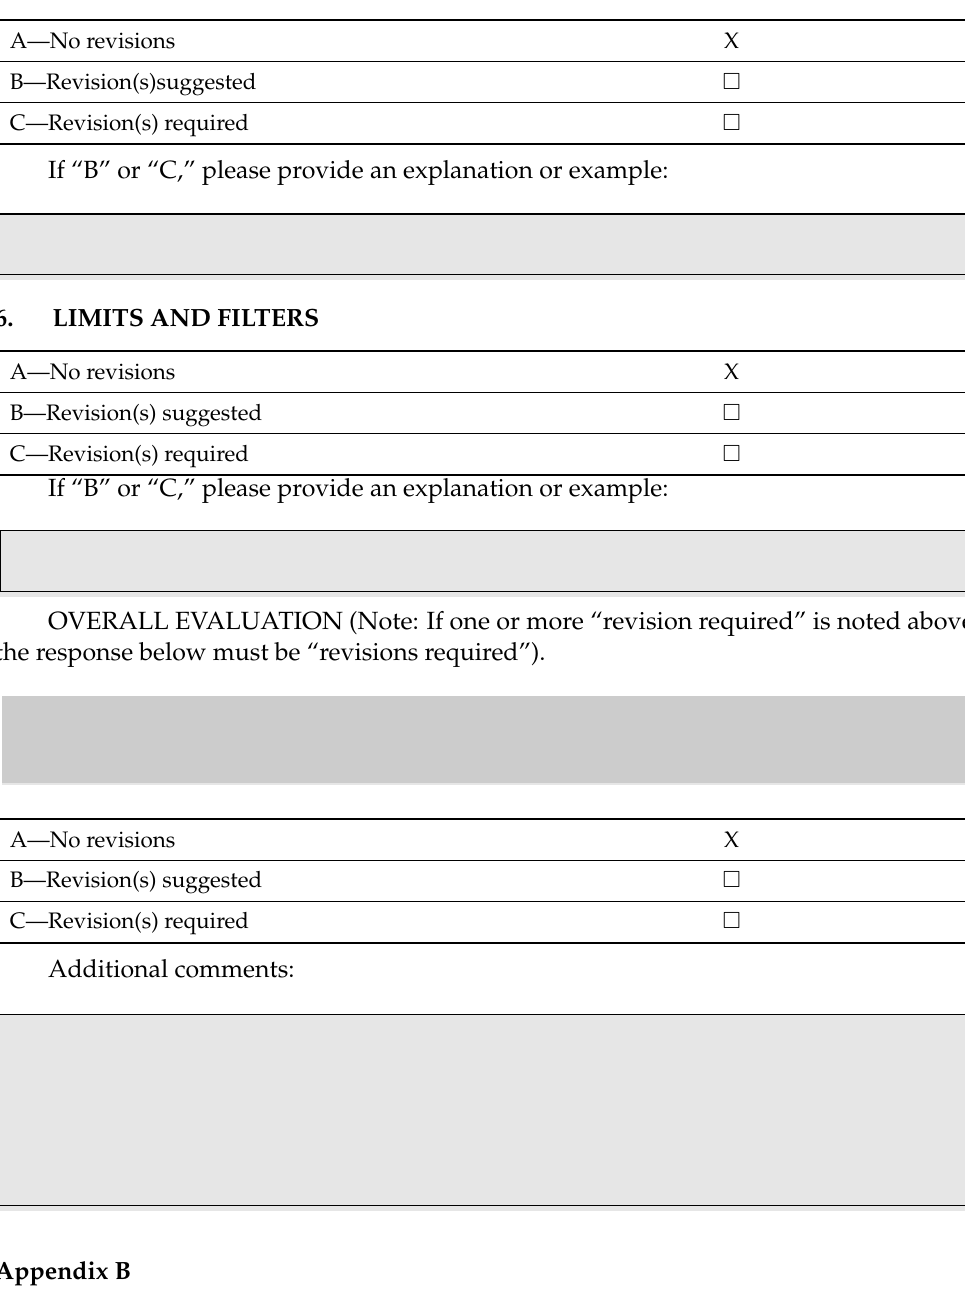
Table A1. Primary and Secondary Outcome Variables.